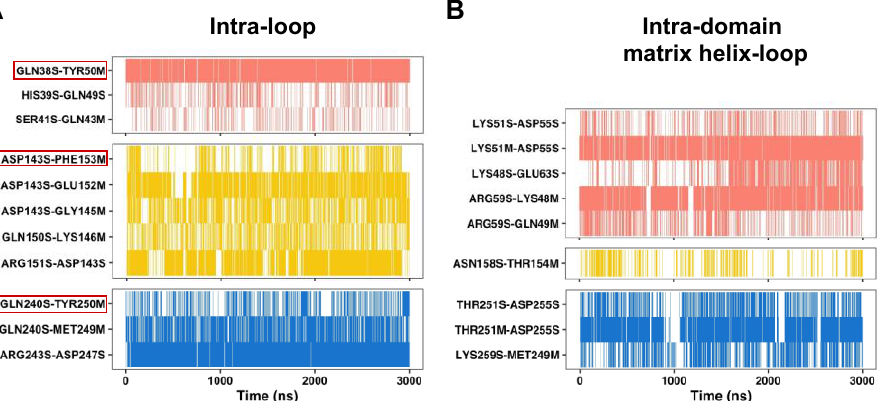
Figure 2. Time evolutions of the intra-domain H-bonds near the matrix side of AAC. ( A ) The intra-loop H-bonds. The H-bonds formed between triplet 38 residues (Q38, D143 and Q240) and the first residues within the [YF]xG motif (Y50, F153 and Y250) are highlighted with red boxes. ( B ) The intra-domain H-bonds formed between matrix helices and matrix loops. The H-bonds in domains 1, 2 and 3 are shown in salmon, yellow and blue, respectively. Results shown in this figure were calculated based on traj-1, and results of traj-2 and traj-3 are provided in the Supplementary Material.